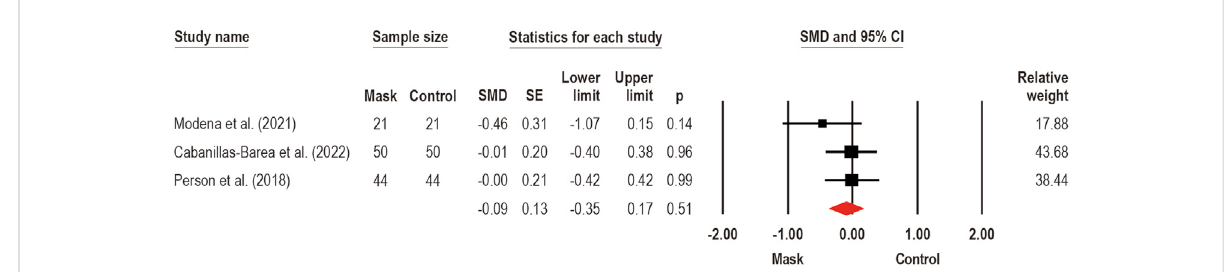
FIGURE 7 Acute effects of face mask vs. control (unmasked condition) on the distance traveled performance during walking and running functional tests. Forestplotswithpooledstandardizedmeandifference(SMD),standarderrors(SE),and95%con fi denceintervals(CI)aredisplayed:(SMD: − 0.09;95% CI − 0.35 to 0.17; p = 0.51; I 2 =